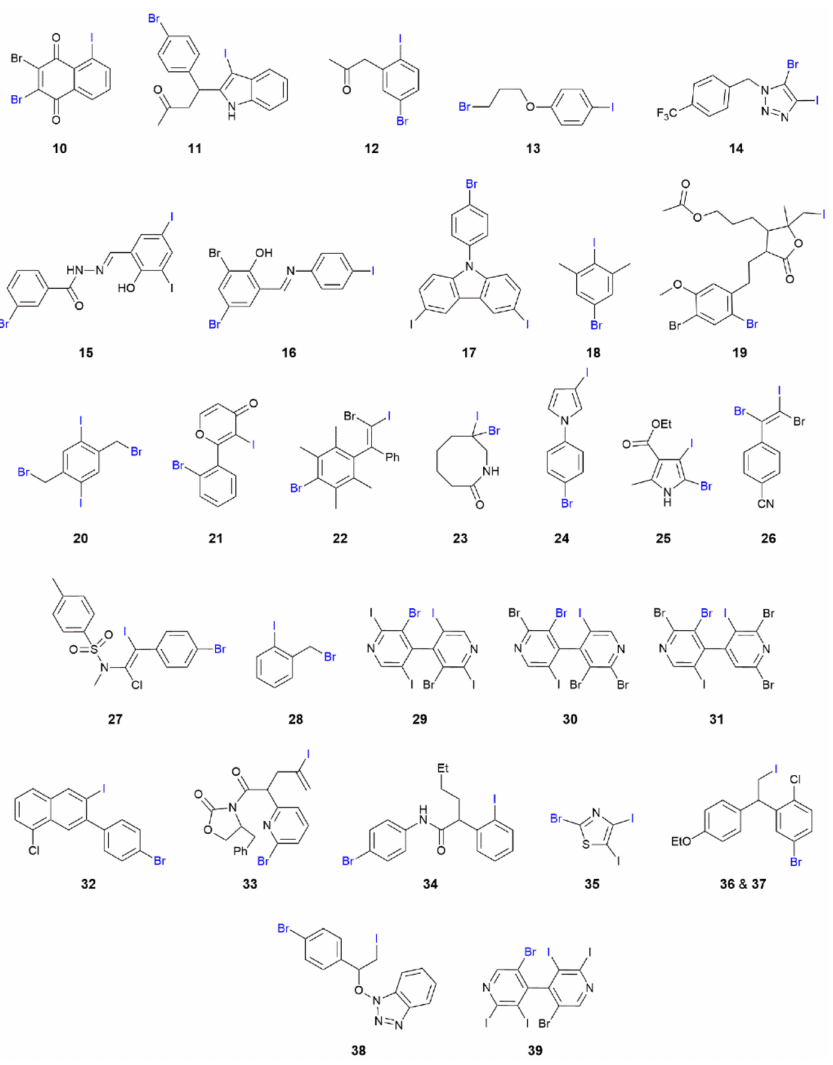
Figure 5. Chemical diagrams for molecules that form I · · · Br interactions in their crystals, leading to one-dimensional aggregation patterns ( 10 – 39